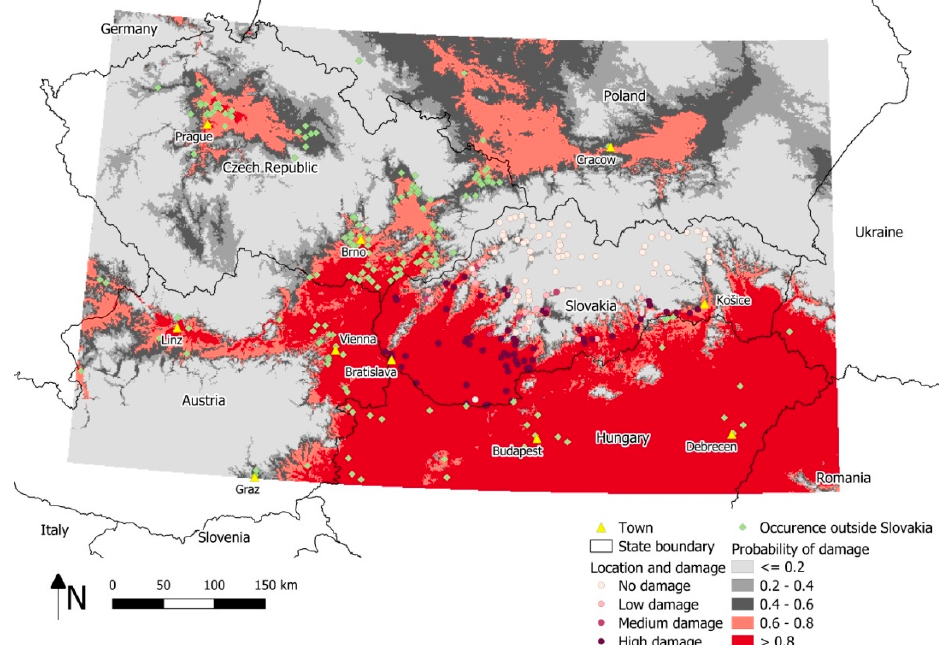
Figure 6. Map of Slovakia and surrounding regions showing the probability of damage to box trees by Cydalima perspectalis predicted by mean annual temperature. Locations and damage to box trees in Slovakia—original (own) data; occurrence outside Slovakia—data from the literature.